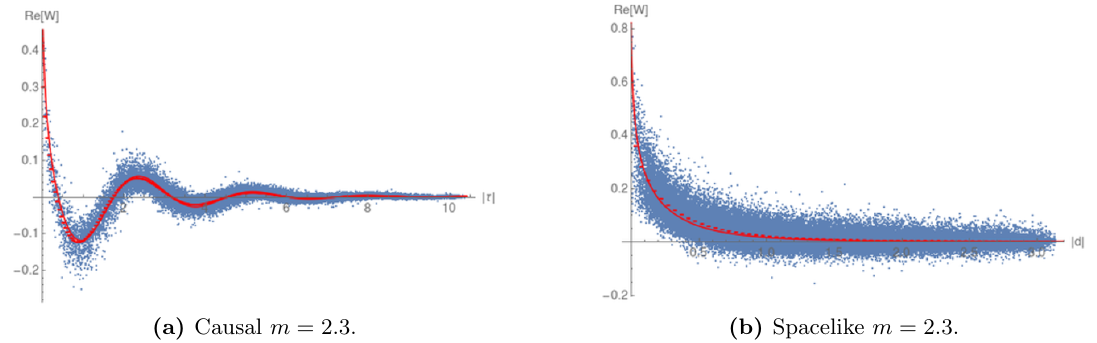
(a) Causal m = 2 : 3. (b) Spacelike m = 2 : 3. Figure 16. N = 36000 ; T = 1 : 56 ; (cid:26) = 30 : 93, in 2d de Sitter. Re[ W sample of 100000 randomly selected pairs. The red curve represents the continuum W E from (5.4).